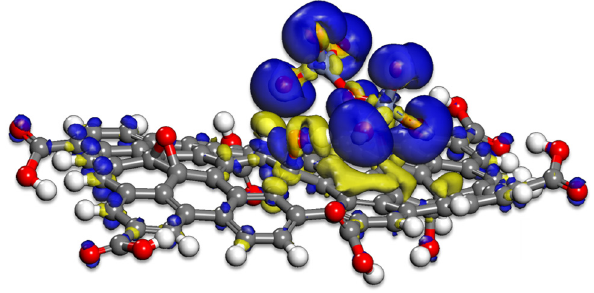
Figure 6: EDD for the adsorbed dichromate ion on the GO surface ( Pose_3 )